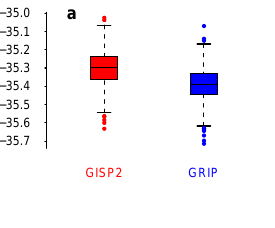
Figure 7. (a) Boxplots of the minima and (b) times of the min- ima from GISP2 and GRIP over the range of 7.9 to 8.5kcalyrBP. The interquartile range of the timing of the event from both cores is (8.12, 8.16, 8.18)kcalyrBP. All estimates are based on 1000 pro- cess 23